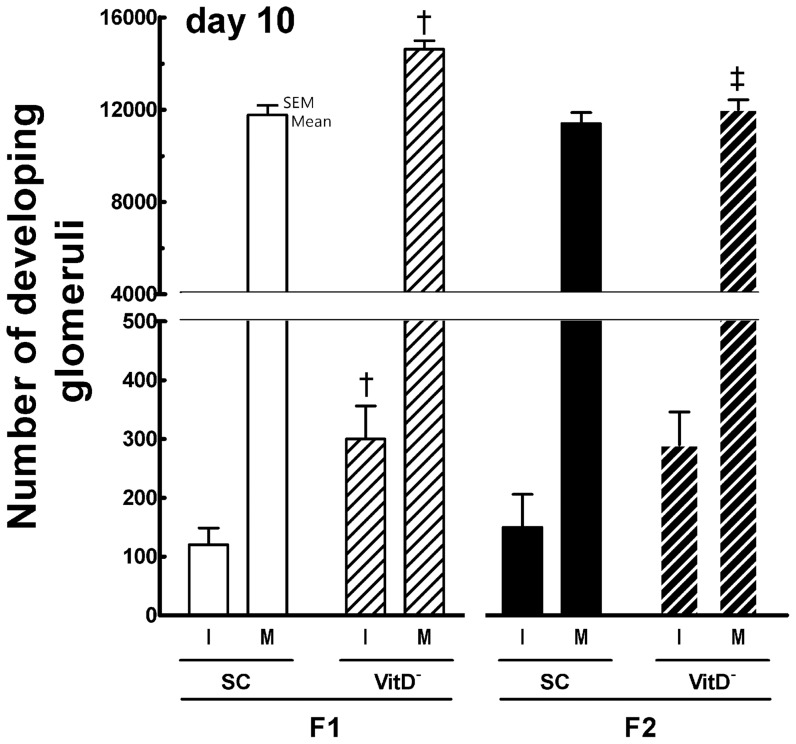
Number of developing immature and mature glomeruli at 10 days in both the F1 and F2 generations.Data are reported as means ± SEM; P<0.05, one-way ANOVA and post-hoc of Tukey's test: † compared to SC counterpart; ‡ compared to F1 generation.